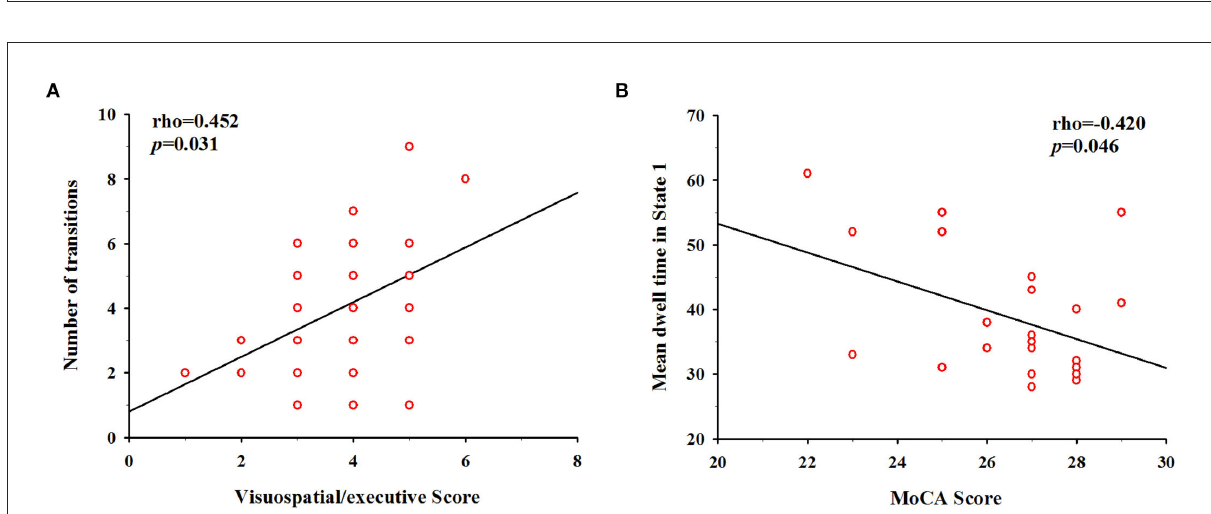
FIGURE5 Correlation between cognitive scores and temporal properties in LA patients. (A) The number of transitions was positively correlated with the visuospatial/executive score (Spearman’s rho = 0.452, p = 0.031). (B) The mean dwell time in State 1 was negatively correlated with